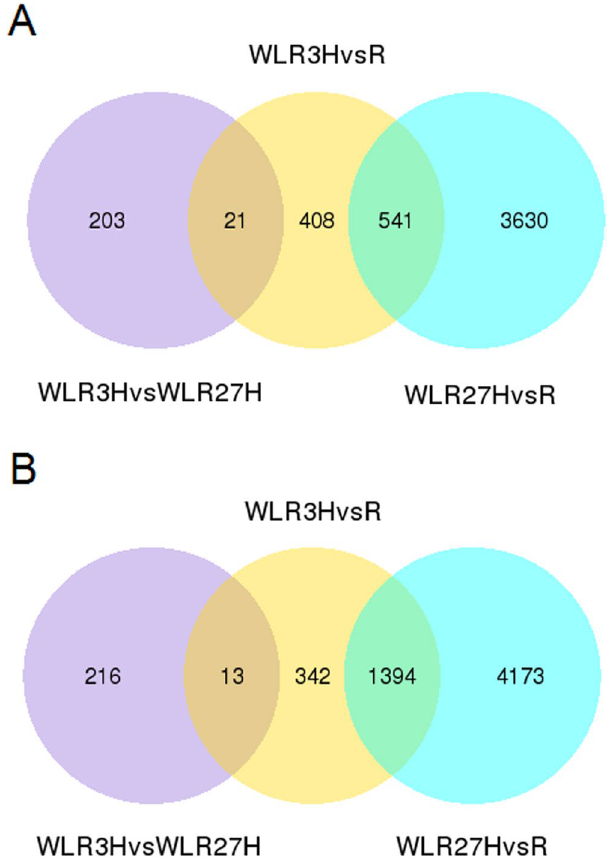
Figure 2. Venn diagrams of differentially expressed transcripts under waterlogging treatment in S. cannabina plantlets. ( A ) Numbers of DEGs exclusively upregulated in each treatment; ( B ) numbers of DEGs exclusively downregulated in each treatment. The numbers of DEGs with common or opposite expression change tendencies between treatments are shown in the overlapping regions. The total numbers of up- or down- regulated genes in each treatment are the sum of the numbers in each